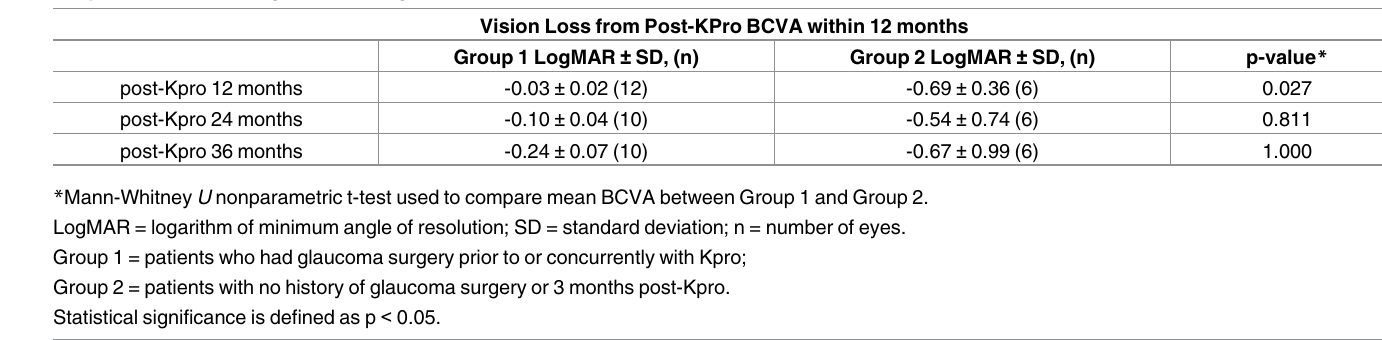
Table 2. Vision loss, as determined by LogMAR of BCVA at severaltime points minus BCVA within 12 months post-Kpro, for patients with or with- out prior or concurrent glaucoma surgical